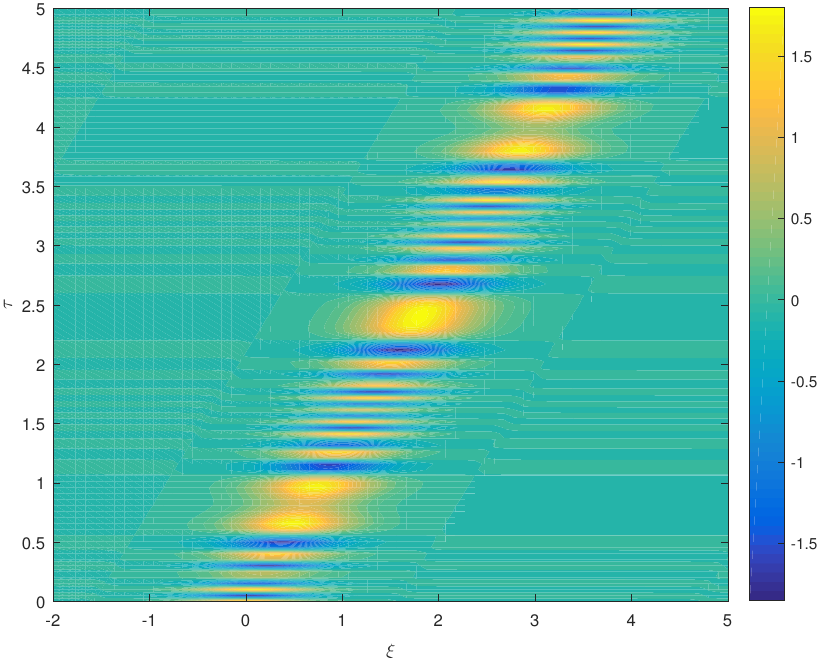
Figure 2. The contour plot of the envelope